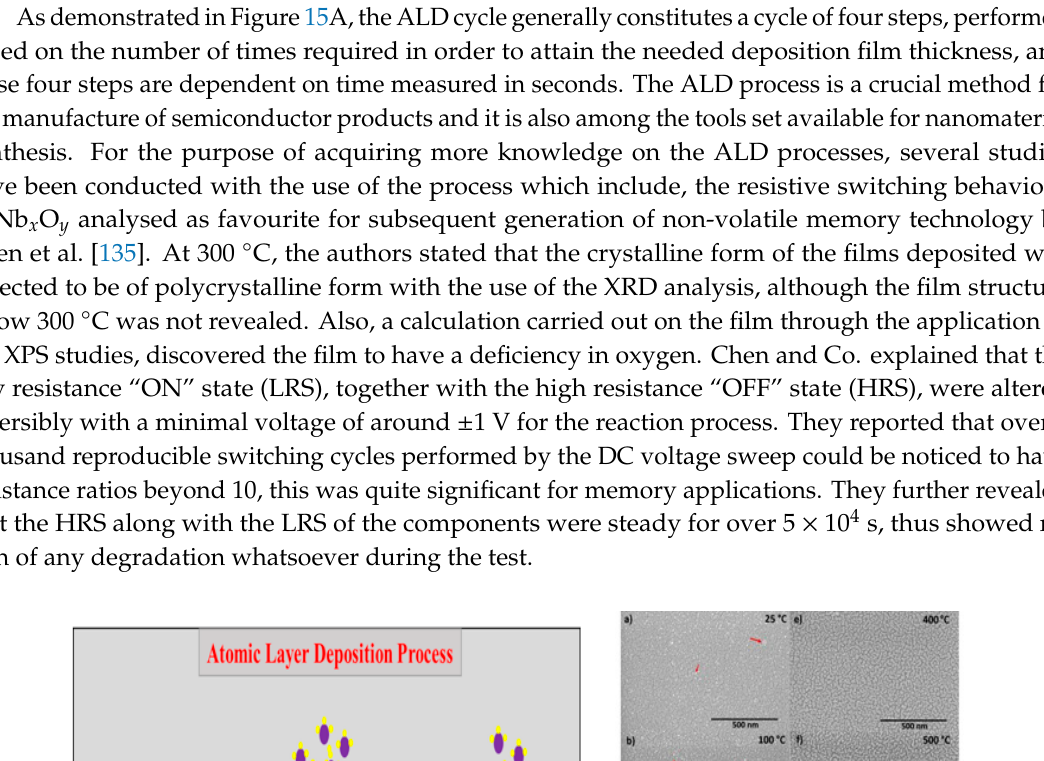
Figure 14. ( A ) Schematic diagram of a conventional CVD reactor , ( B ) SEM images of nanostructured Nb 2 O 5 thin films formed at varying substrate temperatures within the ranges of (a) 500 °C to (f) 1000 °C, in intervals of 100 °C. [130]. Reprinted with permission from [130]. Copyright 2016 ACS Publications.